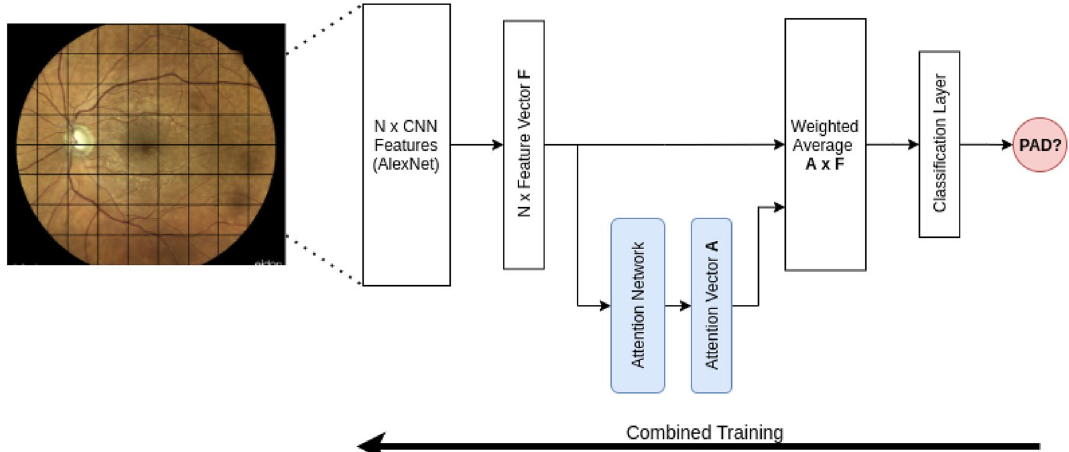
Figure 1. Overview of the attention-based multiple instance learning model. The high-resolution image is subdivided into N patches, which are transformed into N feature vectors by an AlexNet CNN. They are propagated into an attention network that generates a weight for each patch, reflecting the extent to which it should affect the final decision. Based on the attention values, a weighted average of the N feature vectors is taken. It serves as a basis for the final disease prediction. The attention and feature nets are trained